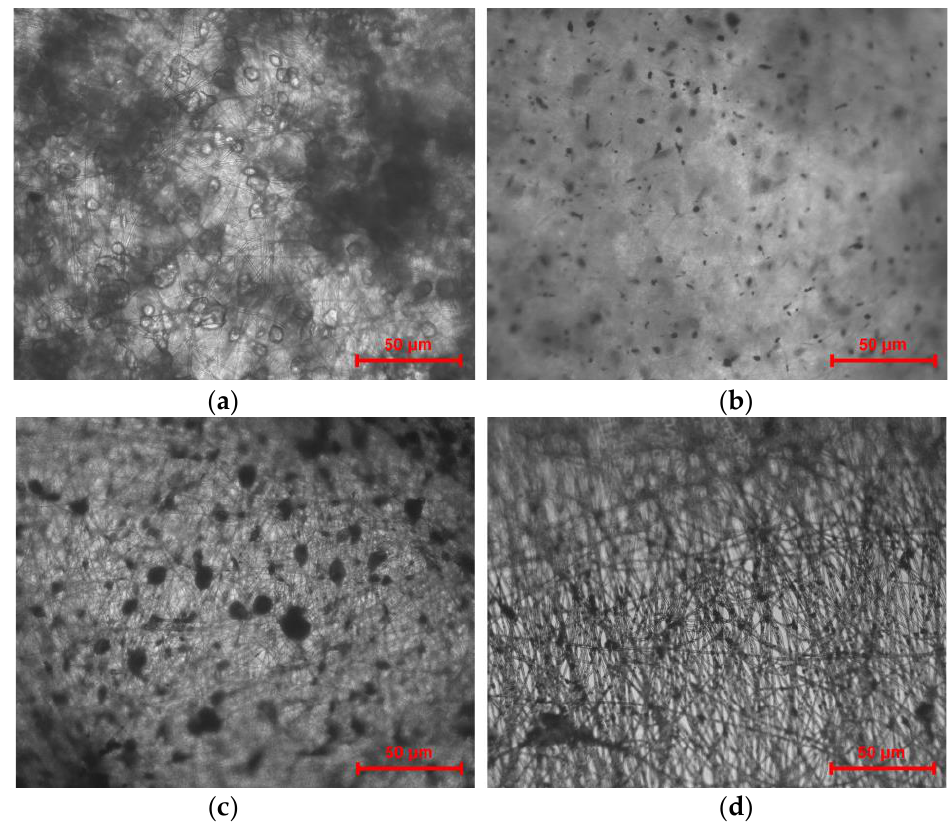
Figure 8. The optical microscopic images of PHB with different hemin content: 0% wt. ( a ), 1% wt. ( b ), 3% wt. ( c ), and 5% wt. ( d ) before fibroblasts seeding BJ-5ta cells. Bar — 50 µm.